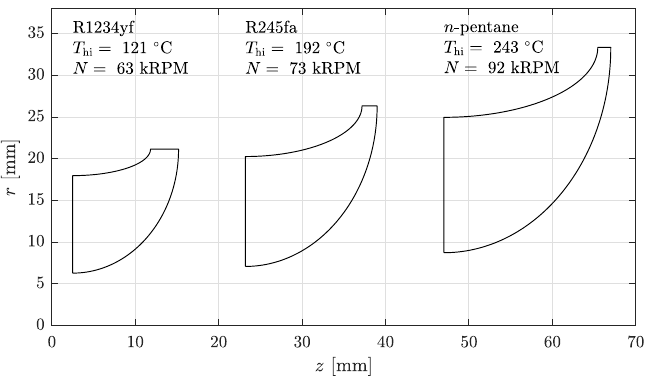
Figure 13. Meridional profiles for three of the optimal turbine designs.